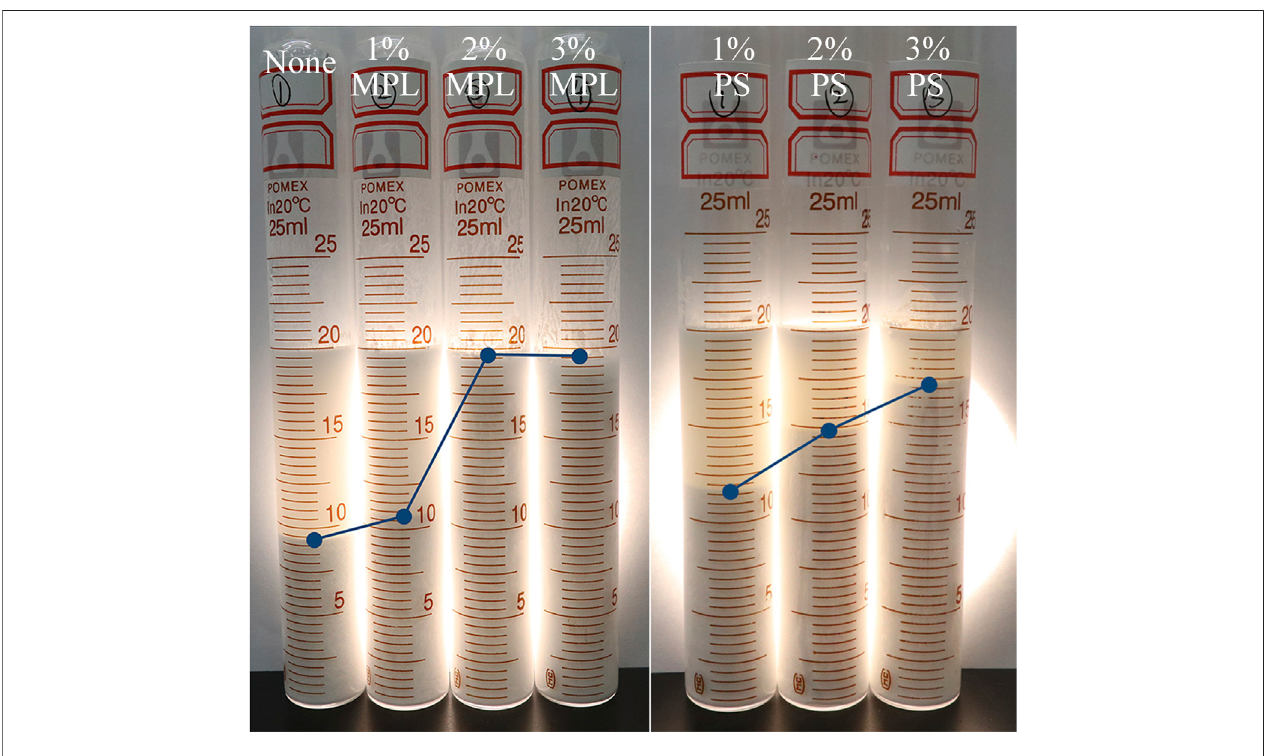
FIGURE 7 | The in fl uence of PS and MPL on the stability of the emulsion. The standing time is 6 h.